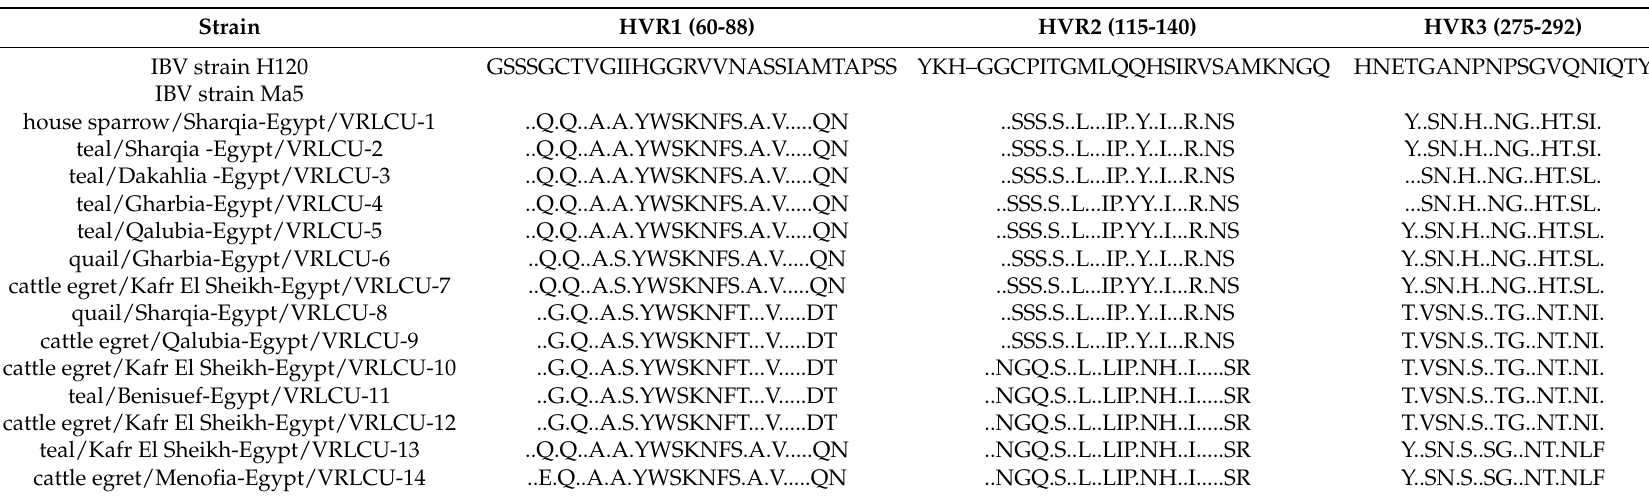
A dot indicates an identical amino acid. A dash indicates an amino acid